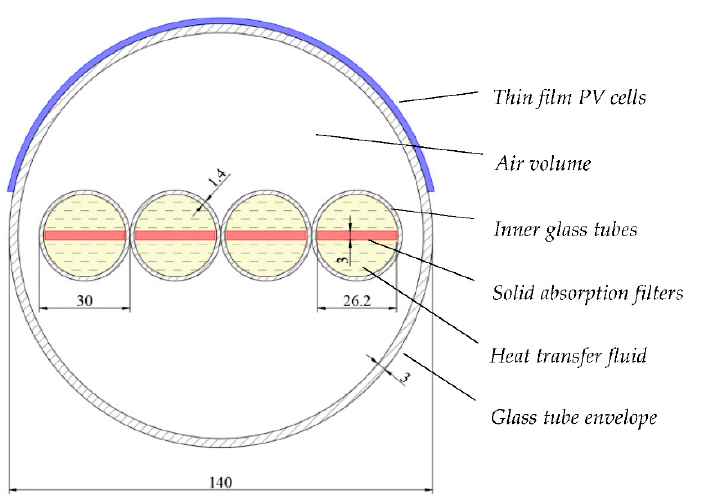
Figure 2. Cross section of the novel CPVT receiver design with bendable PV cells, solid absorption filters and enveloping glass tube (dimensions given in mm).